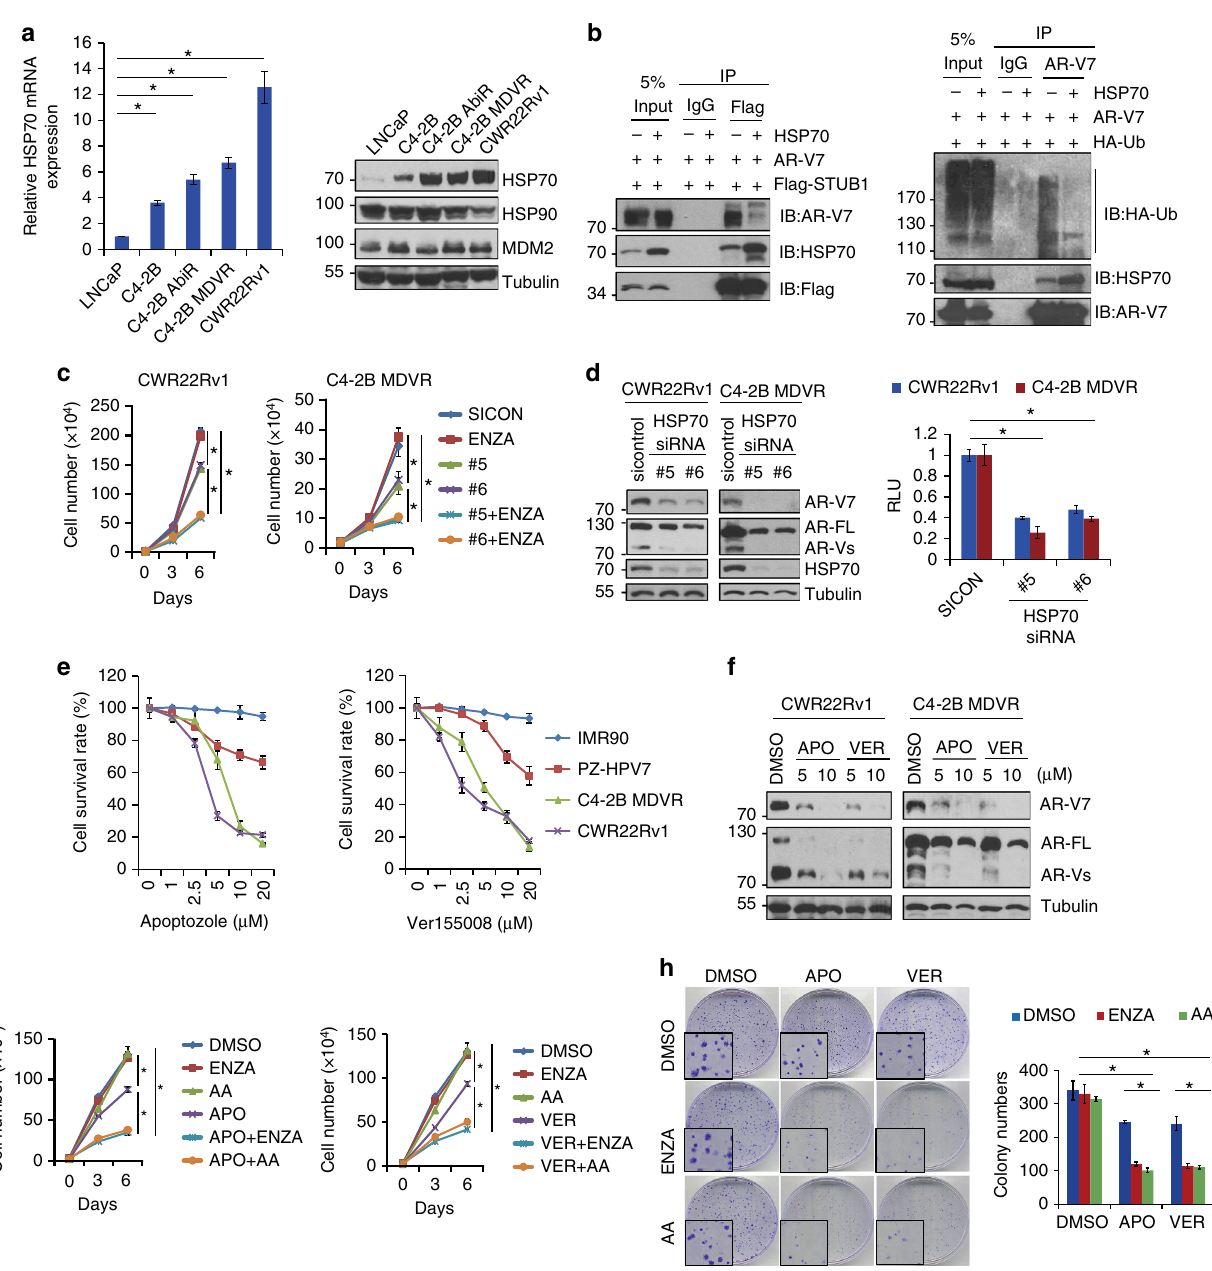
Fig. 3 STUB1/HSP70 complex regulates sensitivity to anti-androgens. a Total mRNA and whole cell lysates from LNCaP, C4-2B, C4-2B AbiR, C4-2B MDVR, and CWR22Rv1 cells were collected and subjected to qRT-PCR and western blot, respectively. b 293 cells were co-transfected with Flag-STUB1, AR-V7, HA-Ub with or without HSP70 for 3 days, whole cell lysates were immunopreciptated with anti-Flag or AR-V7 antibodies and blotted with